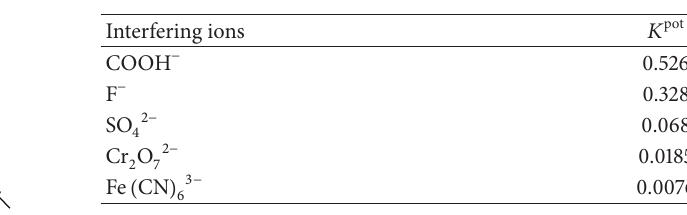
Table 1: Potentiometric selectivity coefficients for nitrate ISE based on CS-MMT composite